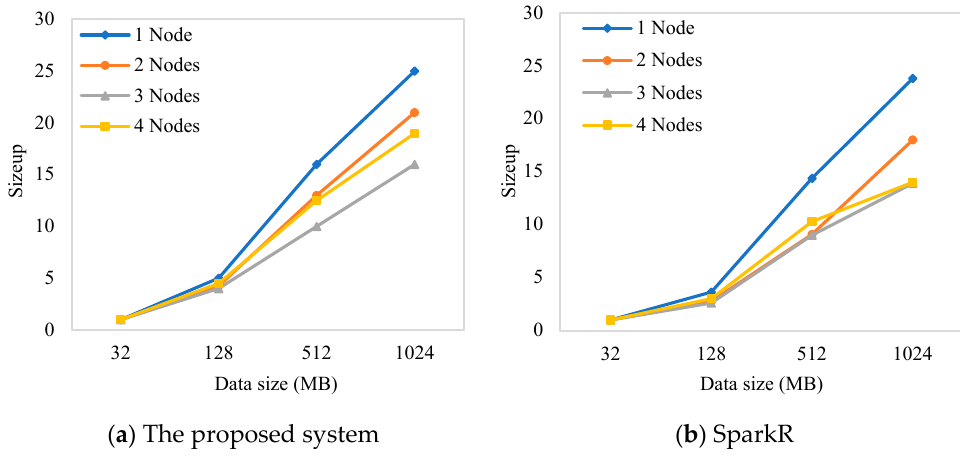
Figure 6. Comparison with regards to sizeup.